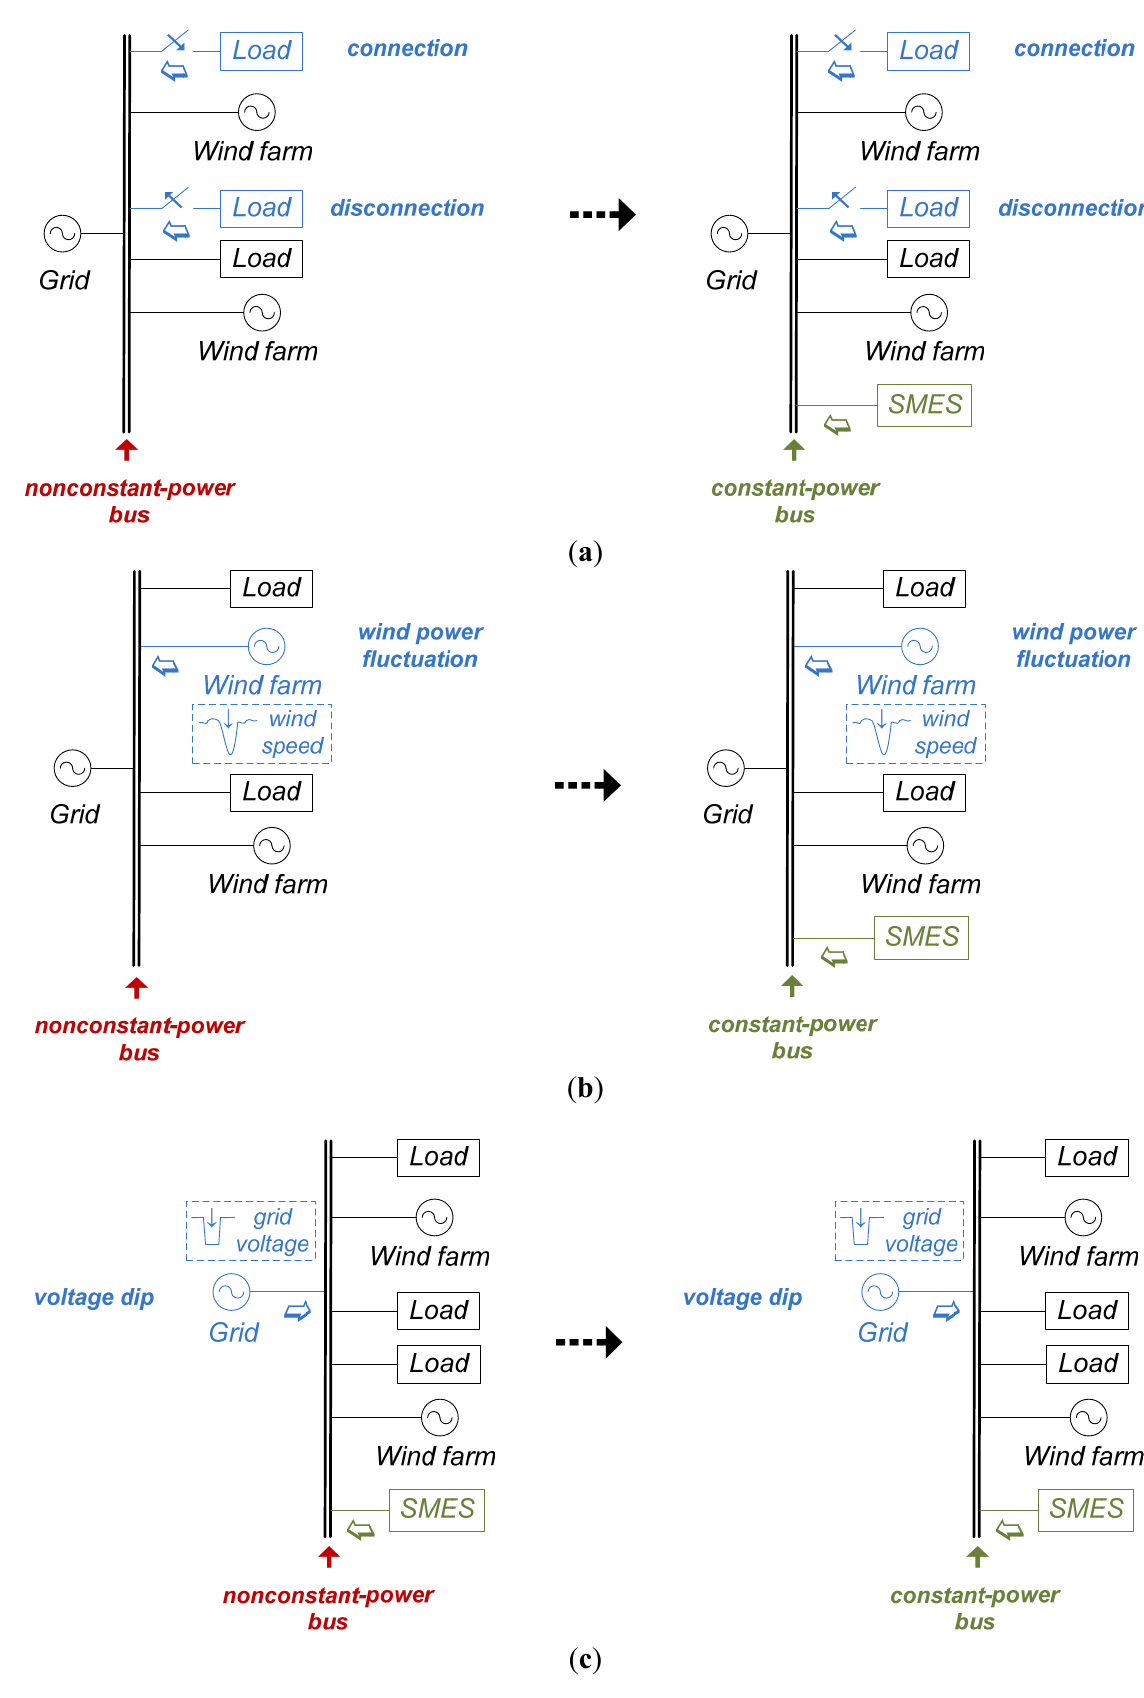
Figure 1. Applications of SMES systems: ( a ) load-step; ( b ) load-sharing; and ( c ) grid-support. Left/right-side scheme shows the power system behavior without/with SMES